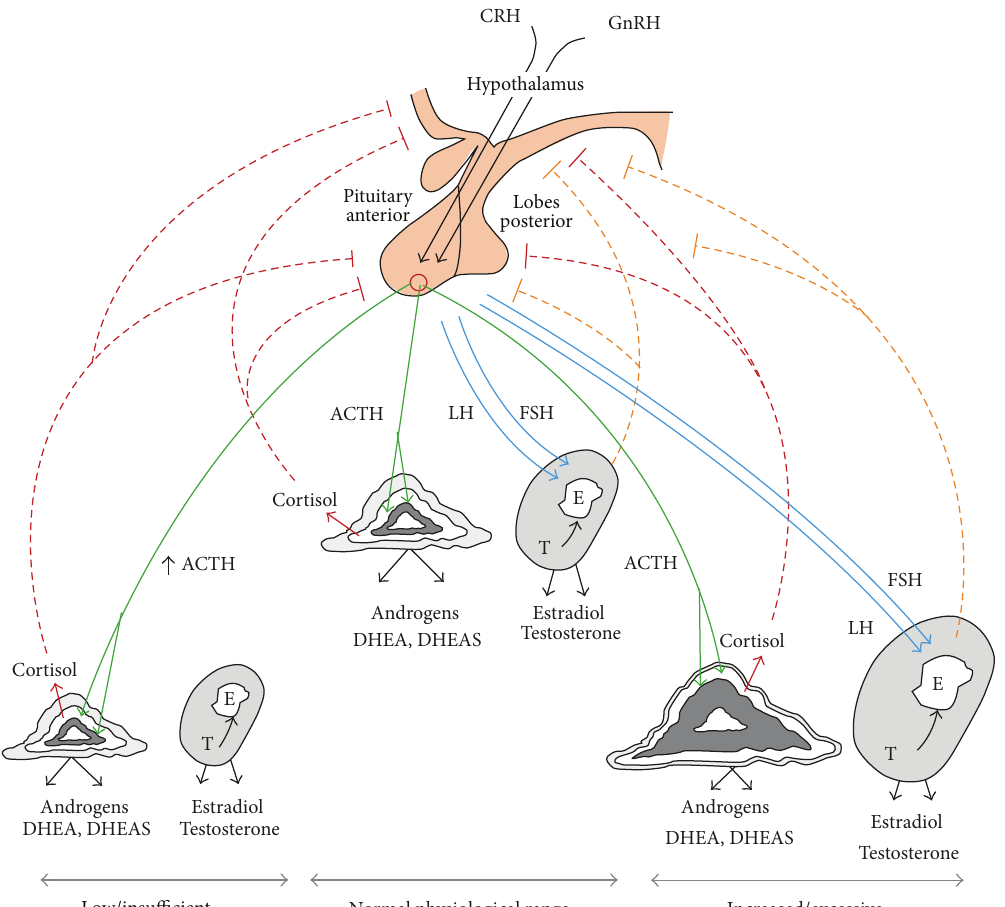
Figure 2: An inductive categorical schema of adrenal cortical and ovarian tropic (ACTH, LH, and FSH) and trophic (steroidogenic cell mass or competency) influences on cortisol, adrenal androgen (AA), and sex hormone production, in relation to AA status in females. Negative feedback control of the hypothalamic-pituitary-adrenal (HPA) and ovarian (HPG) axes is illustrated. Solid lines indicate stimulation and dashed lines indicate inhibition, within the respective systems. Direct and indirect interactions between the respective HPA and HPG axes are not illustrated. The HPA axis can inhibit the HPG axis at multiple levels and estrogen may stimulate the HPA axis [17]. The enlarged ovary model portrays tropic (LH, FSH) and trophic mechanisms operating in polycystic ovarian syndrome (PCOS), rather than a normally large gland. The adrenal cortex and ovary are derived from a common embryonic anlage. It is not known if trophic influences can cause an “ enlarged adrenal organ syndrome ,” analogous to PCOS. Regarding low adrenal and low ovarian gland sizes, defined syndromes are also not documented, but individual variation and diminishing size occur in natural aging. Cortisol is synthesized mainly in the zona fasciculata (ZF, white area), which has the largest mass of the adrenal cortex (circa 70%). The AAs, DHEA and androstenedione, are mainly produced in the zona reticularis (ZR, darker grey area), which has the smallest mass (circa 10%). In females, the AAs are the major source of androgenic compounds. The mineralocorticoids are synthesized in the outermost zona glomerulosa (ZG, light gray area), which has a medium mass (circa 20%) of the adrenal cortex. Cortisol and AA production are stimulated by ACTH secretion in a pulsatile pattern under regulation of the hypothalamic-pituitary (H-P) axis. Cortisol, in turn, inhibits the H-P in a negative feedback manner. It directly suppresses hypothalamic corticotropin releasing hormone (CRH) and its action on the pituitary secretion of ACTH. Insufficiency of cortisol leads to less inhibition of the CRH-ACTH axis and to increased ACTH. In normal aging, cortisol levels are fully maintained in the setting of decreased AA production and associated decreased ZR mass. The overall size of the adrenal cortex is stable in aging, but the outer cortical zones (ZG and ZF) are relatively increased in size to the diminished ZR [18]. The ovarian AA steroids are androstenedione mainly and testosterone (T), which lack negative feedback inhibition at the H-P levels, a function accomplished by estrogen